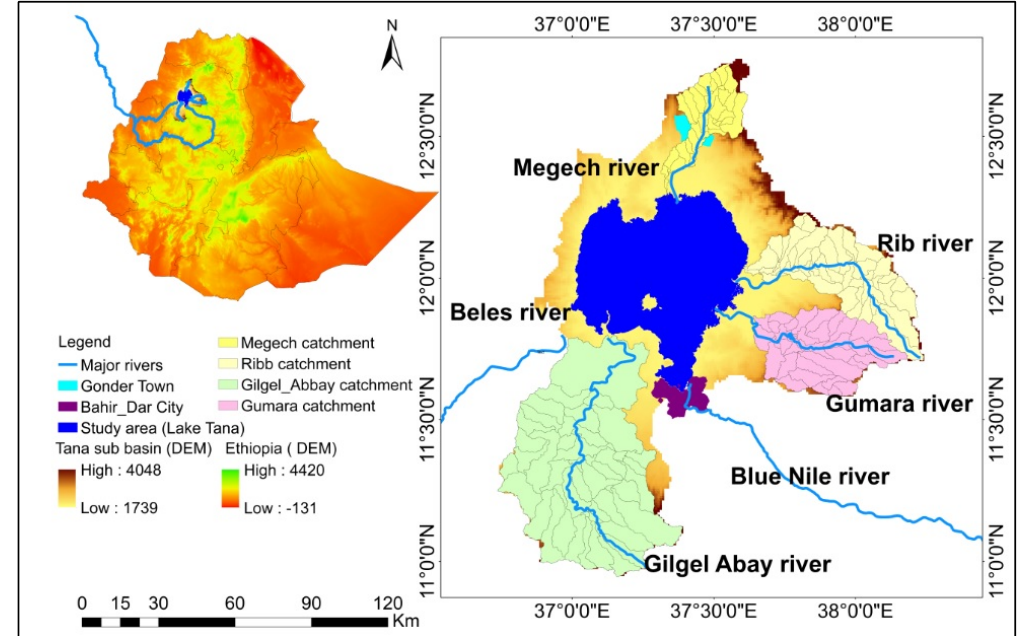
Figure 1. Elevation map of Ethiopia (left) and the Tana sub basin (right) with gauged catchments and Lake Tana (the study area which was prepared by using the maximum historical lake level at 1788.2 m a.s.l).